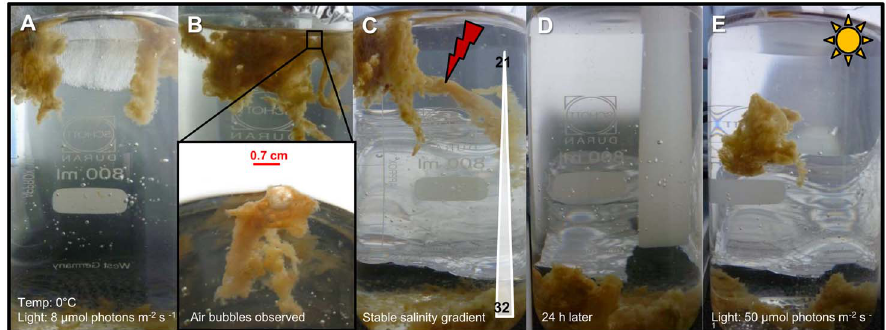
Figure 5. Buoyancy test. (A) A piece of ice with several attached filamentous algal aggregates was kept in a glass beaker at simulated in situ conditions. (B) Once the ice disappeared it was observed that air bubbles were trapped in the mucous matrix of the floating aggregates. (C) Despite the salinity gradient, one of the aggregates sank when the air bubbles were removed. (D) 24 h later all algal aggregates had sunk. (E) Only when increasing the light intensity, some of the algal aggregates were able to produce enough oxygen to regain buoyancy. Scale bar=2 cm.